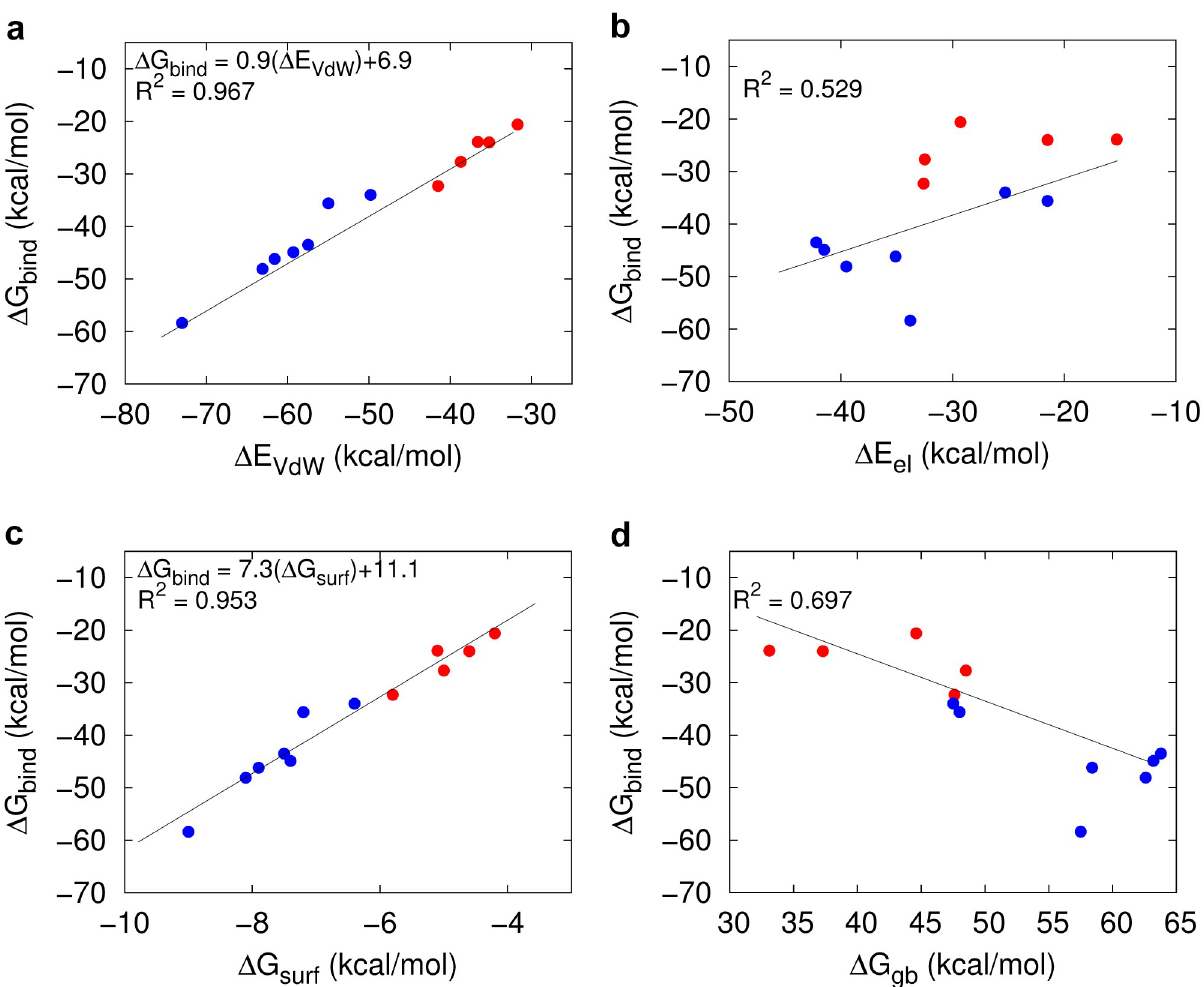
Fig 5. Correlation between total binding affinity ( Δ G bind ) and its individual components. a-b) Van der Waals ( Δ E VdW ) and electrostatic ( Δ E el ) contributions to the interaction energy, respectively. c-d) nonpolar ( Δ G surf ) and polar ( Δ G gb ) solvation free energies, respectively. The binding affinities and their components were calculated by MMGBSA for the cluster representatives extracted from the SrtA-Ca (blue points) and the SrtA-noCa (red points) simulations, respectively.